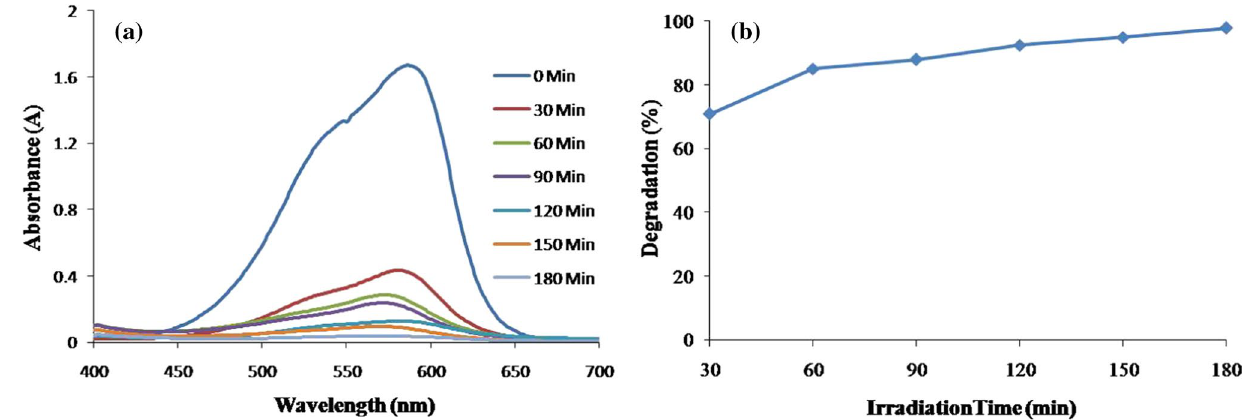
Fig. 7 a UV–Vis spectra of MV dye photodegraded by Co/cross-linked chitosan, b %degradation of MV dye photodegraded by Co/cross-linked chitosan